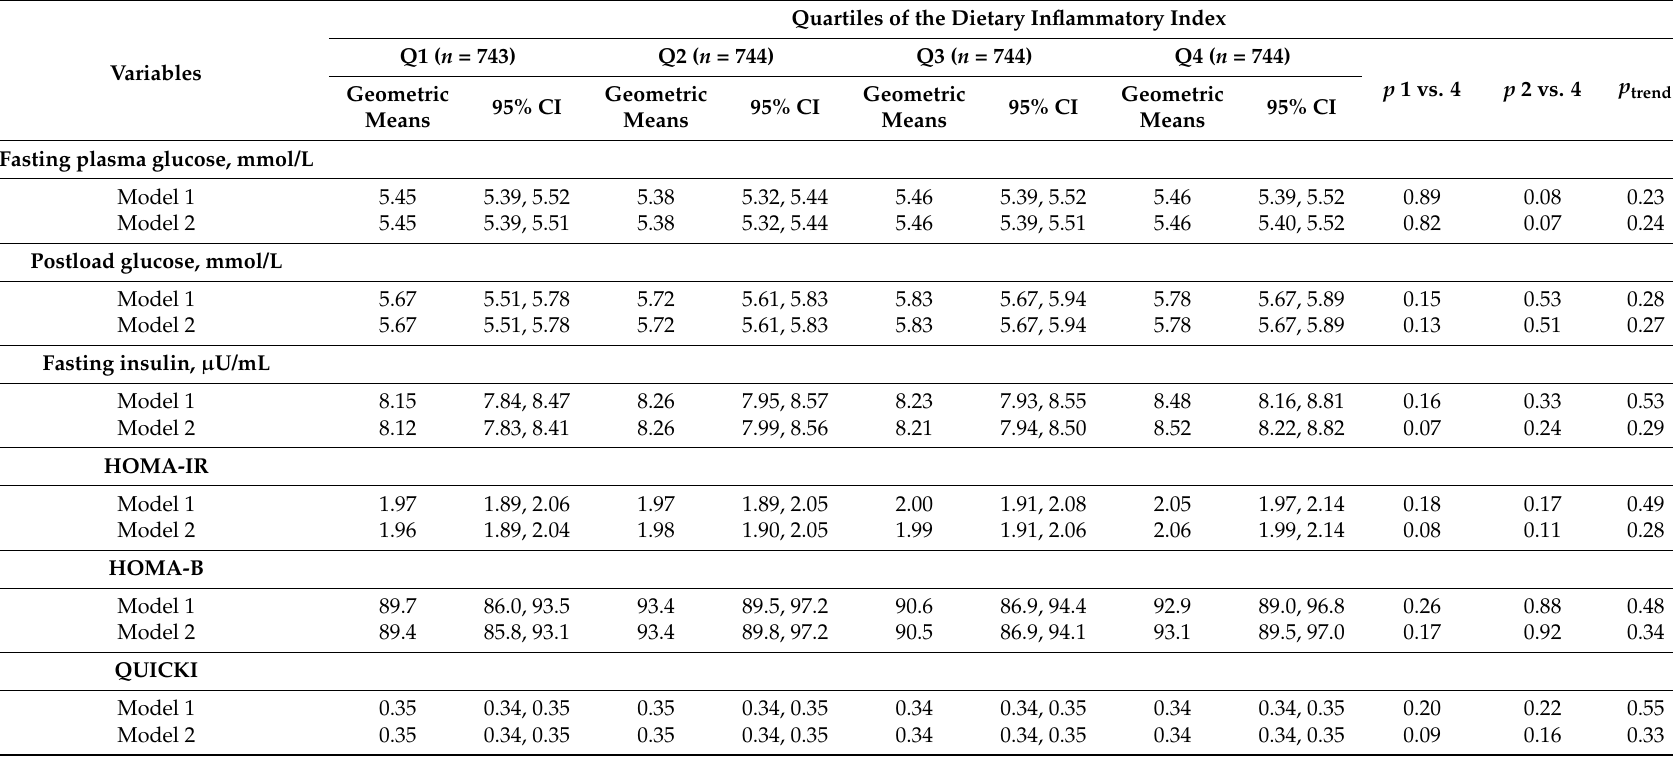
Table 3. Adjusted mean (95% confidence interval) of glucose-insulin homeostasis markers according to quartiles of the dietary inflammatory index